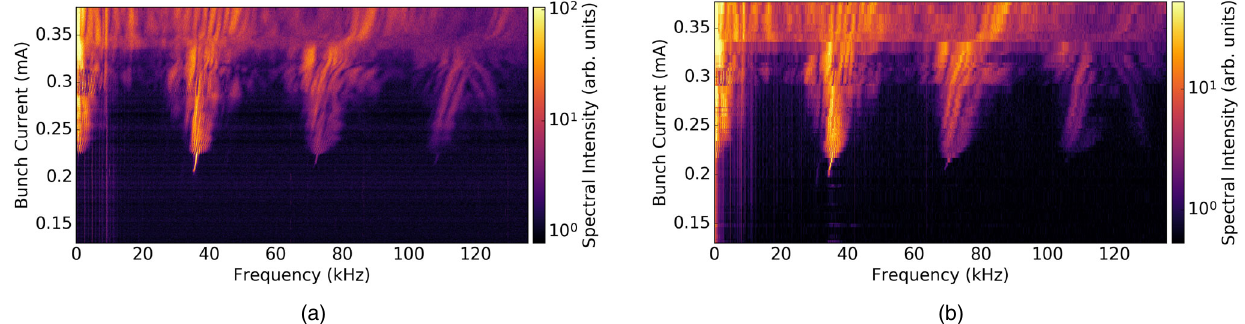
FIG. 3. The spectrogram shown in (a) was obtained from measurements of a single bunch for slowly changing beam current lasting two and a half hours, while the spectrogram in (b) was obtained from a snapshot measurement lasting just one second by using the FFT of THz signals similar to those shown in Fig. 1. For the snapshot measurement the bunch current resolution is limited by the number of bunches and their current distribution. Compared to this, the standard measurement during a slow current decrease results in a higher current resolution. Despite the limited resolution of the snapshot spectrogram, the dominant bursting frequencies and the thresholds between different bursting regimes are clearly visible.